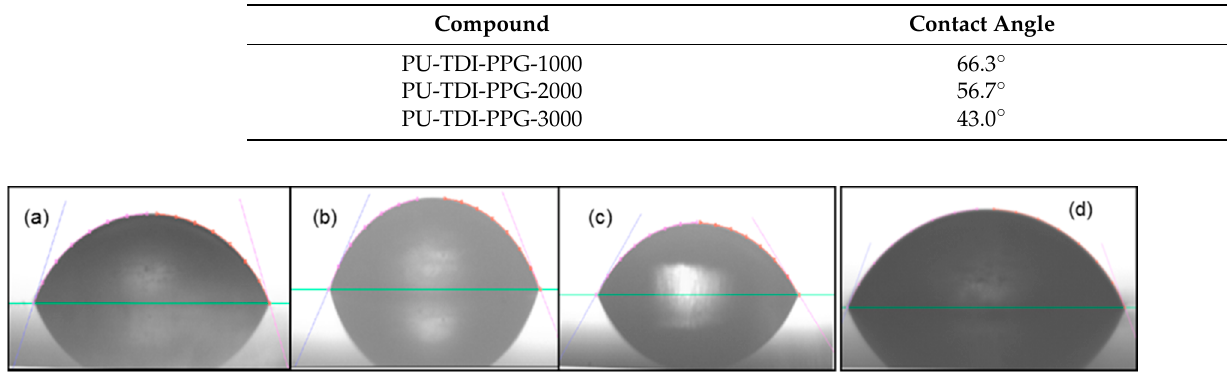
Figure 7. Water droplets on the coated surfaces for the determination of the contact angle of ( a ) PU-TDI-PPG-1000, ( b ) PU-TDI-PPG-2000, ( c ) PU-TDI-PPG-2000 and ( d ) blocked isocyanates.